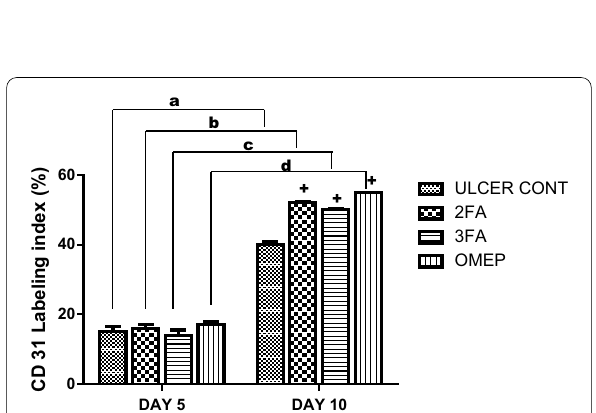
2 mg/kg Folic acid, = Omeprazole =